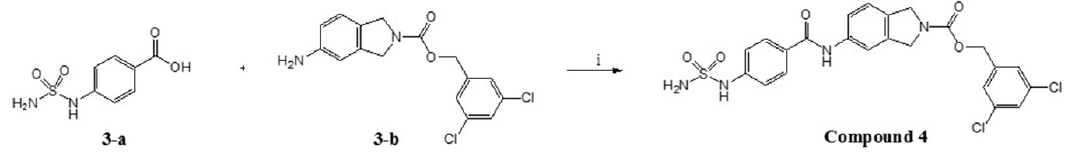
Figure 4. Comparison of the binding modes of compound 1 (orange stick model) and compound 2 (yellow stick model). The distance between CO groups of compound 1 and compound 2 was found to be 0.97 Å. The CO group of compound 2 was located closer to the L’ region. The centers of mass of water networks and zinc atoms are represented by red and dark blue spheres, respectively.